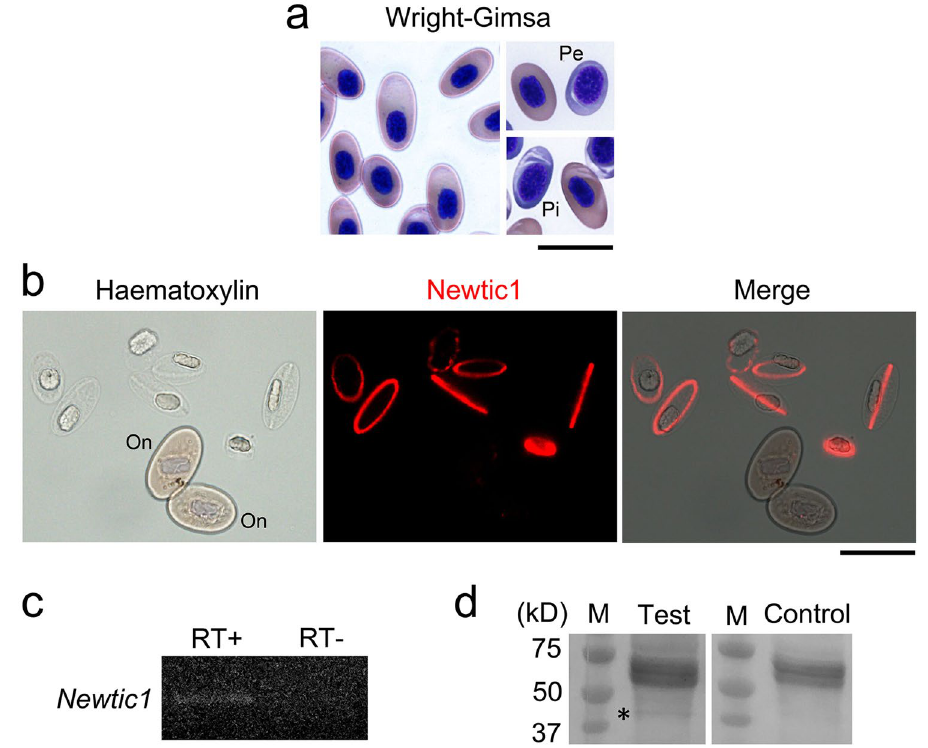
Figure 2. Newtic1 is specifically expressed in a subset of erythrocytes. ( a ) Adult newt erythrocytes. Wright-Giemsa stain of blood smear (peripheral blood) revealed a large number of nucleated erythrocytes (normoblasts) (n = 10; Supplementary Figure S7). Most of them (~99%) were polychromatic normoblasts (PcNobs) at different developmental stages. PcNobs were mostly pink/orange in color of their cytoplasm (late stage), but sometimes grey (intermediate stage; Pi) or blue (early stage; Pe) (for definitions, see Supplementary Figure S7). Scale bar, 40 μ m. ( b ) Newtic1 immunoreactivity in blood cell suspensions (n = 9). Under this set of experimental conditions, almost all PcNobs became slightly swollen and transparent. Newtic1 immunoreactivity was exclusively observed along the equator of those PcNobs. Nuclei were lightly stained with haematoxylin. On: presumptive orthochromatic normoblasts (Supplementary Figure S7). Scale bar, 40 μ m. ( c ) Confirmation of the presence of Newtic1 transcripts in blood cells (n = 3). Total RNA was purified from whole blood cells (proportion of normoblasts was estimated 83–94%). The 497 bp sequence of Newtic1 was amplified by RT-PCR (RT + ), but not without reverse transcription (RT − ). Products were electrophoresized on the same gel (for full-length image, see Supplementary Figure S6b). ( d ) Confirmation of the presence of Newtic1 protein in blood cells (n = 3). Western blotting was carried out with protein samples purified from whole blood cells. Newtic1 antibody (Test) labeled a band corresponding to Newtic1 protein (40.7 kD; asterisk), while RFP antibody (Control) did not. The membranes for Test and Control were stained separately. The 60–70 kD bands were caused by a non-specific reaction of the secondary antibody. M: